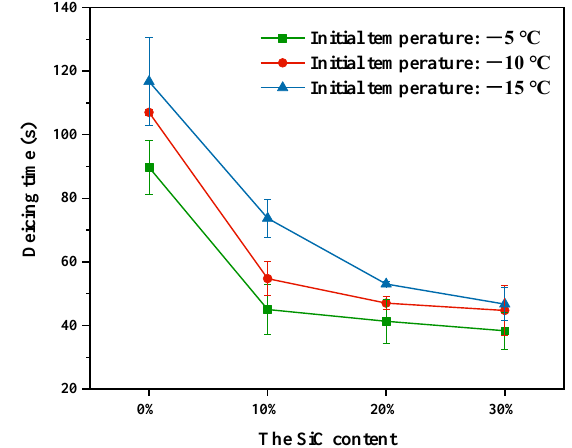
Figure 11. Temperature rise rate of UMLs with different SiC contents.